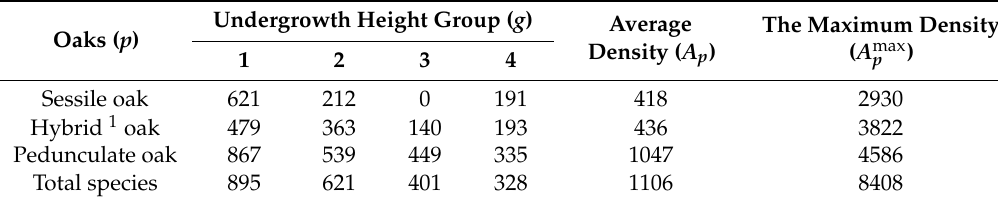
Table 1. The average density of oak undergrowth ( A p,g ), units/ha (Equation (2)).